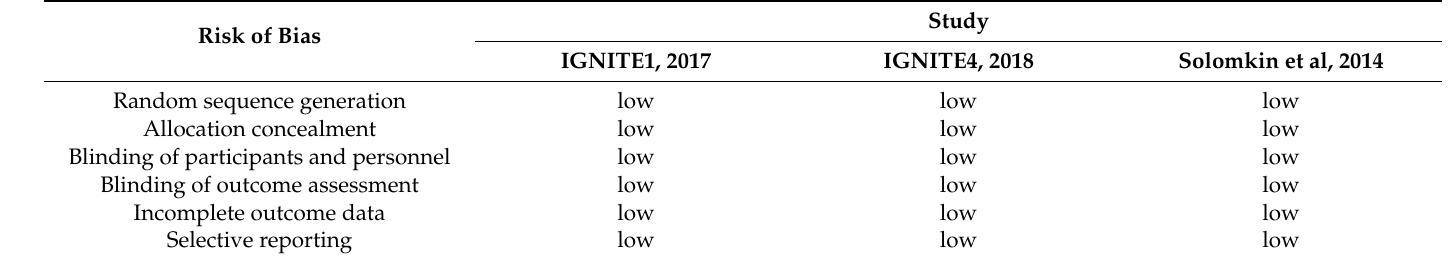
Table 2. Risk of bias per study and